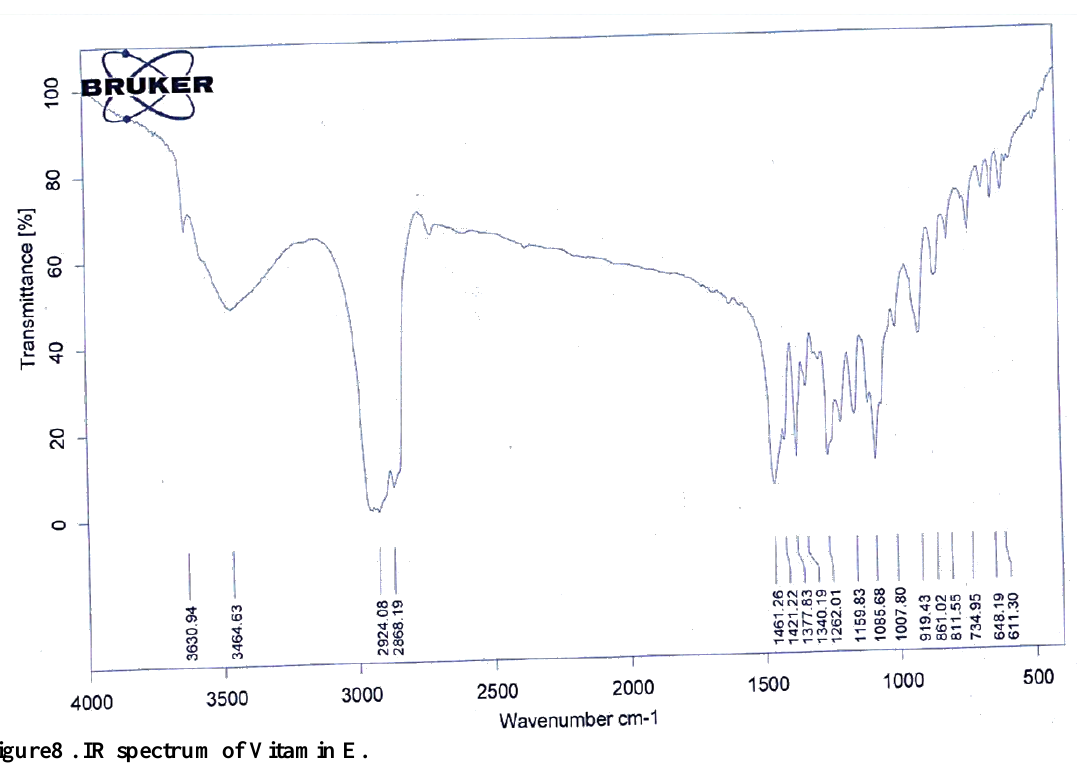
Figure8 . IR spectrum of Vitamin